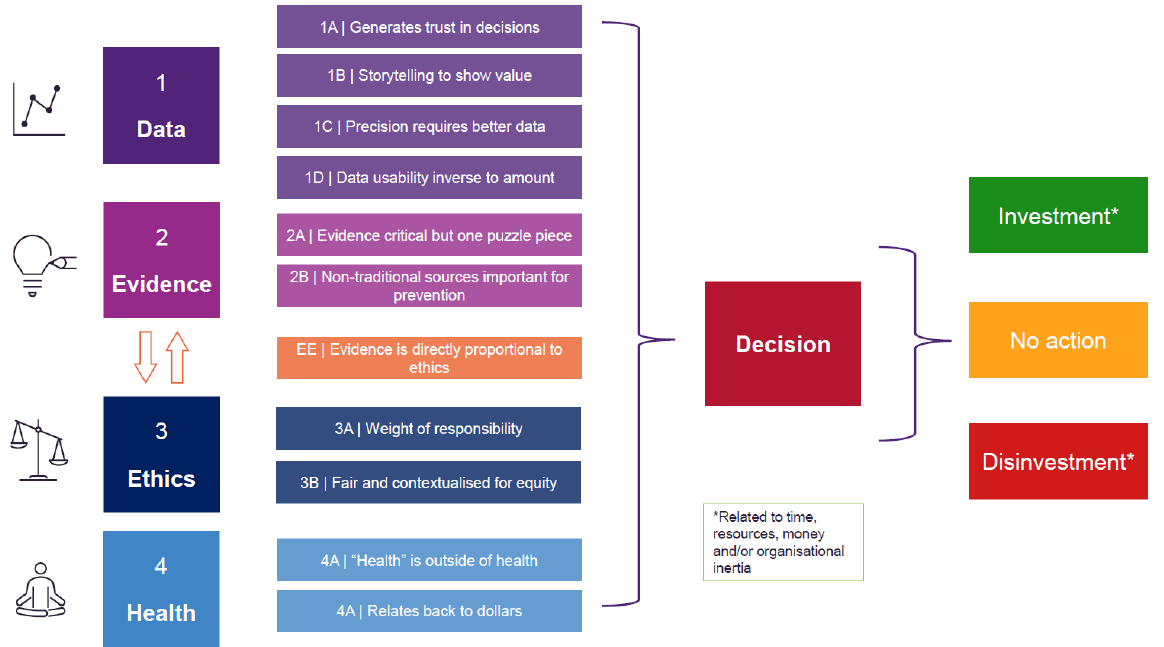
Figure 2. PREVIDE (PREVention decIDE) — a decision-making framework for noncommunicable disease prevention in healthcare organisations.